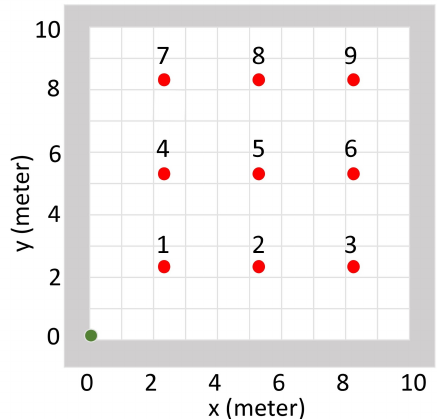
Figure 6. Experiment setup for the radiation source estimation test. The simulation area does not have walls inside. The green dot illustrates the starting point of the detector, and the red dots illustrate nine different testing source positions indexed from 1 to 9.